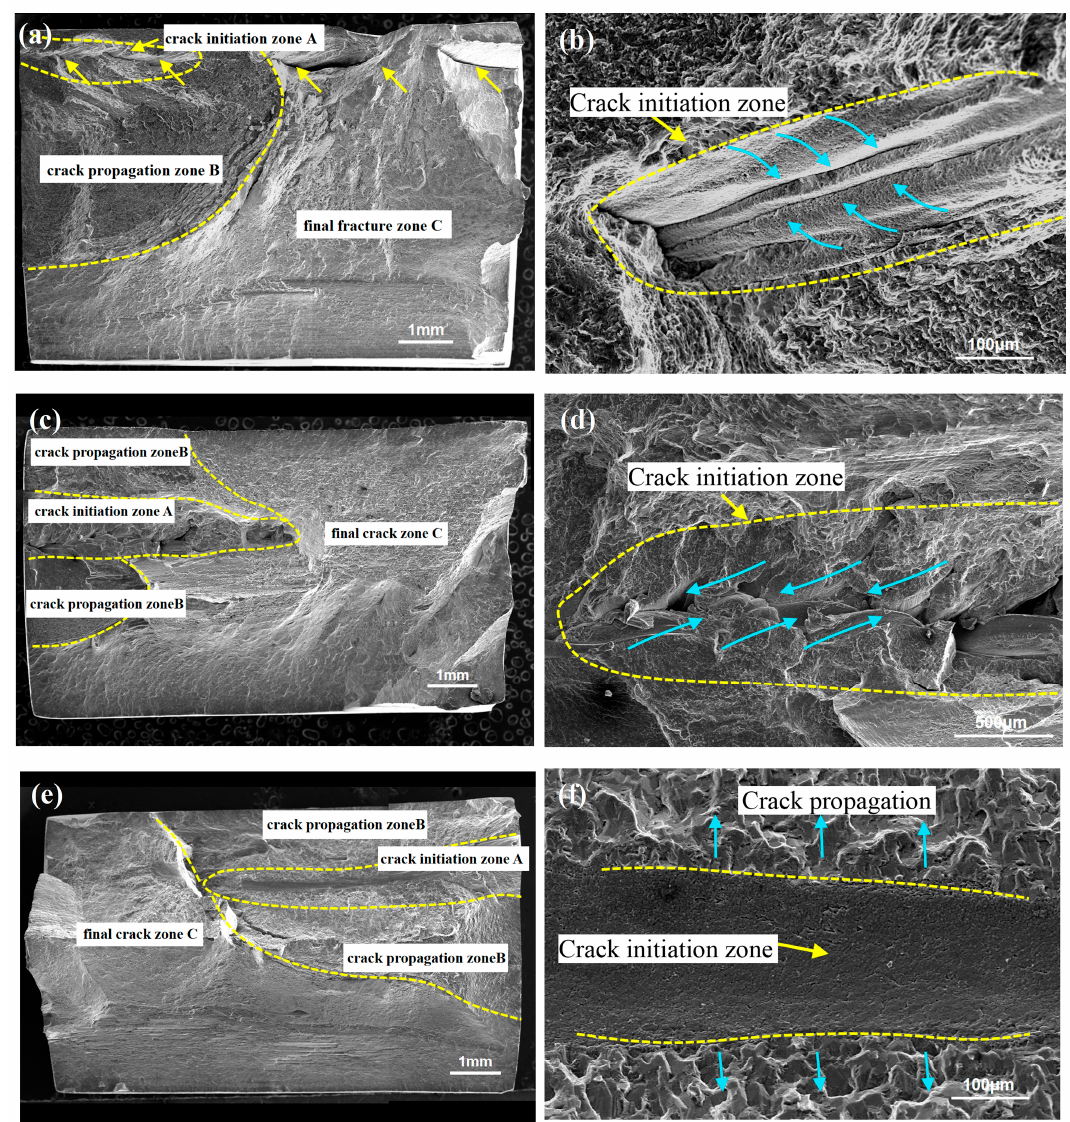
Figure 13. Fracture morphologies of the FSW specimens at the maximum stresses of 230–210 MPa: ( a ) 230 MPa; ( b ) crack initiation zone in Figure 13a; ( c ) 220 MPa; ( d ) crack initiation zone in Figure 13c; ( e ) 210 MPa; and ( f ) crack initiation zone in Figure 13e.